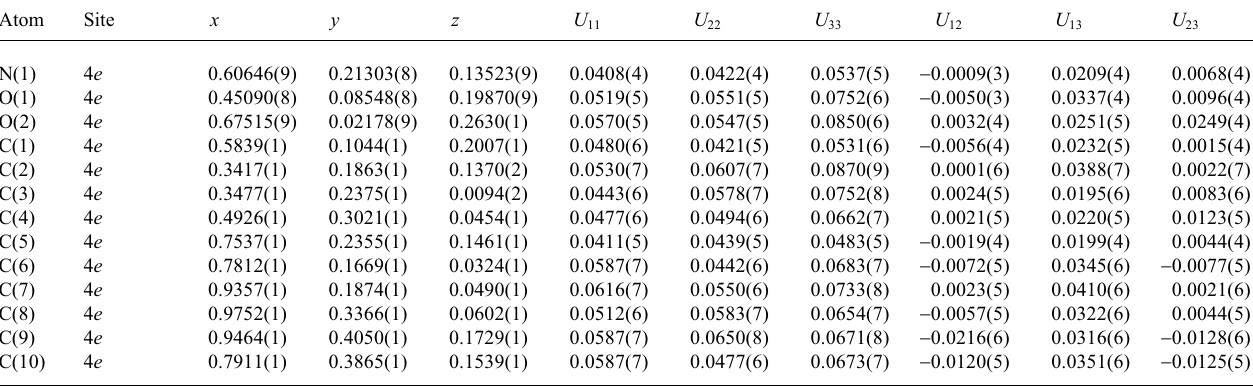
Table 3. Atomic coordinates and displacement parameters (in Å 2